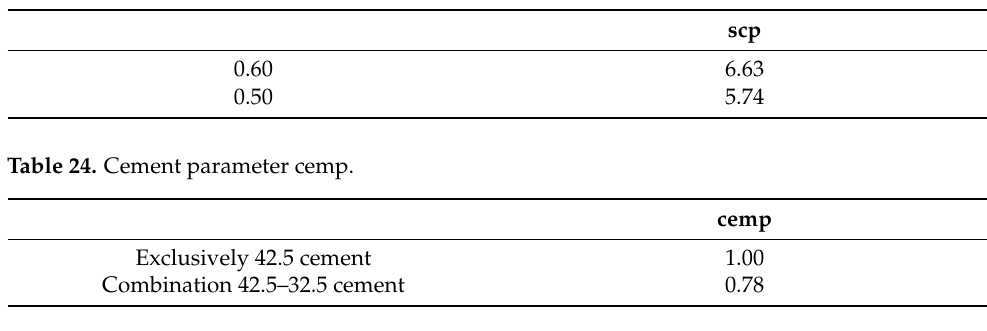
Table 23. Ratio w / c parameter scp.